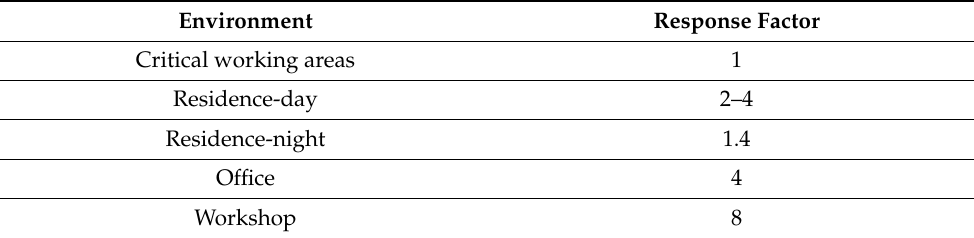
Table A3. Critical vibration levels at which the probability of adverse comments is low, presented in CCIP-016 and BS 6472 (1992).